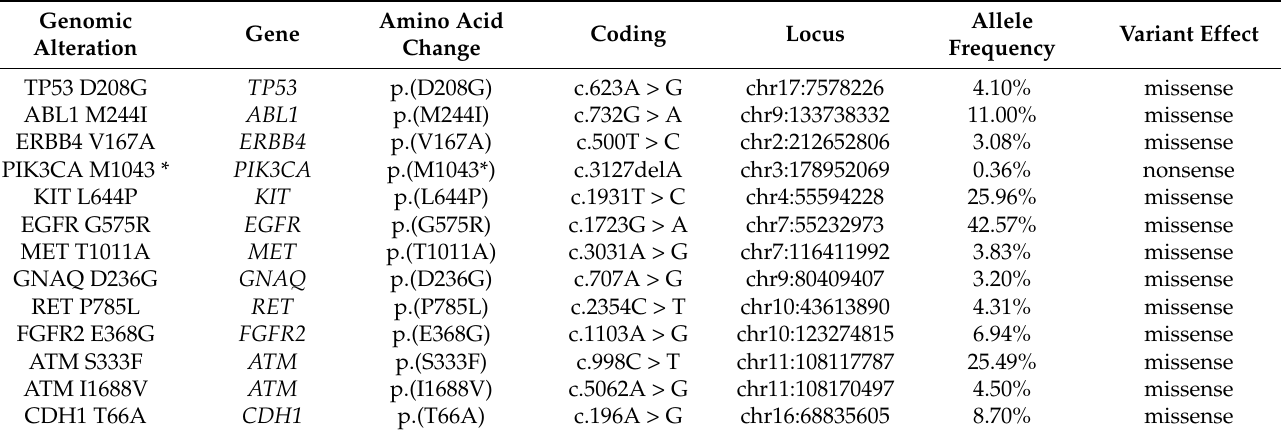
Table 1. Genomic alterations that were detected in the histologically normal tissue. Allele frequency below 50% was considered a somatic mutation [6]. No synonymous variants were included in the table even if the allele frequency was below 50%, but are included in the Supplementary Materials. * Automatic reporting from Ion Reporter and Oncomine Reporter of mutations for the most advanced phase (IV, III, II/III, II, I/II, I) is shown and multiple clinical trials may be available.